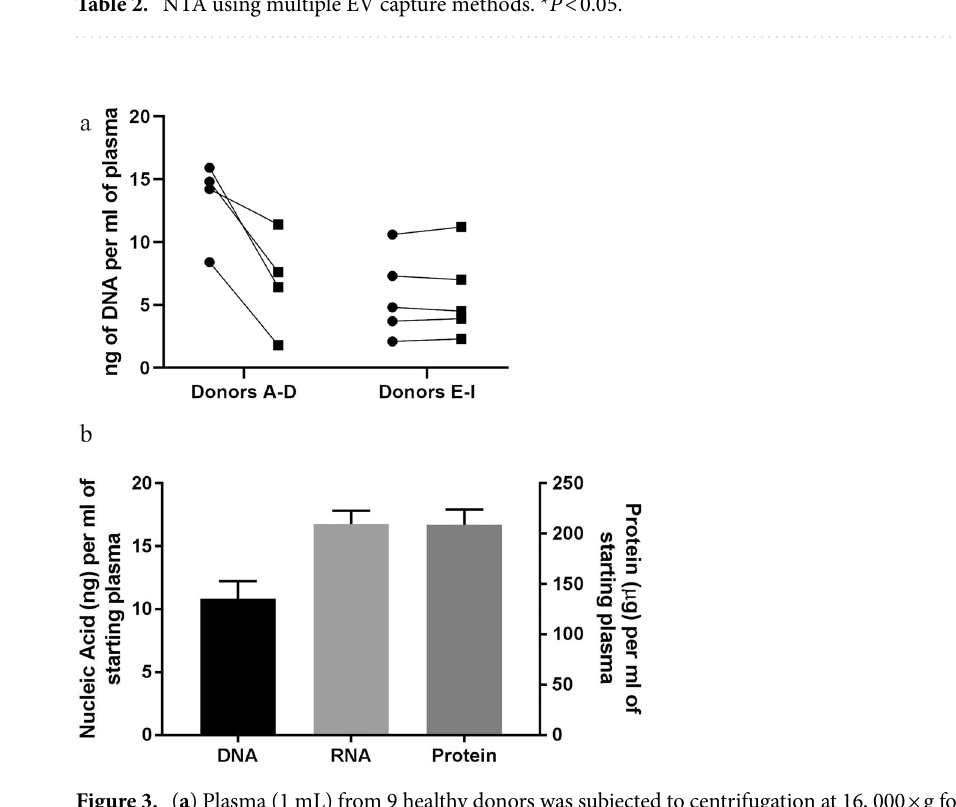
Figure 3. ( a ) Plasma (1 mL) from 9 healthy donors was subjected to centrifugation at 16, 000 × g for 10 min (squares) or not (circles) prior to the addition of Vn96 (100 µg) for EV isolation. DNA was extracted using the Qiagen Circulating Nucleic Acid Kit (Qiagen, cat # 55,114) and quantified with ddPCR using an RNASE P TaqMan Assay. ( b ) DNA, RNA and protein yields per mL of starting plasma. Yields of DNA and RNA (ng) on the left y-axis and protein (µg) on the right y-axis ± SEM per mL of starting plasma (n =